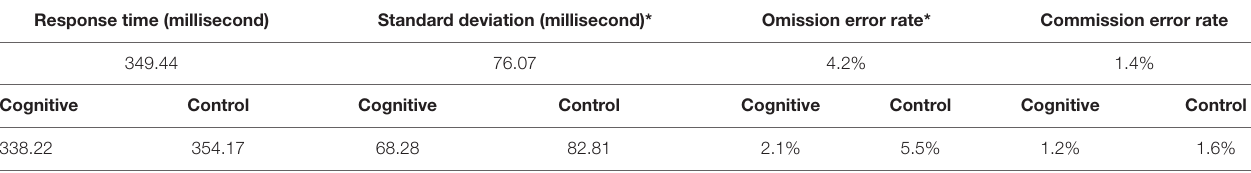
TABLE 3 | Descriptive statistics for the CPT measures, overall and divided by conditions: MPH-CogniCognitive induction, MPH-control induction. Response time